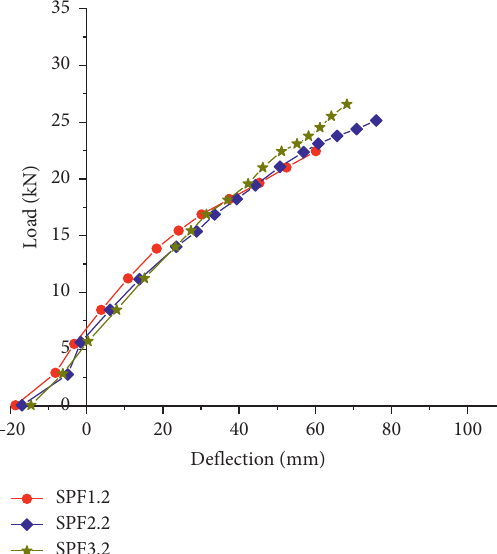
Figure 7: Load-deflection curve of test beams in group